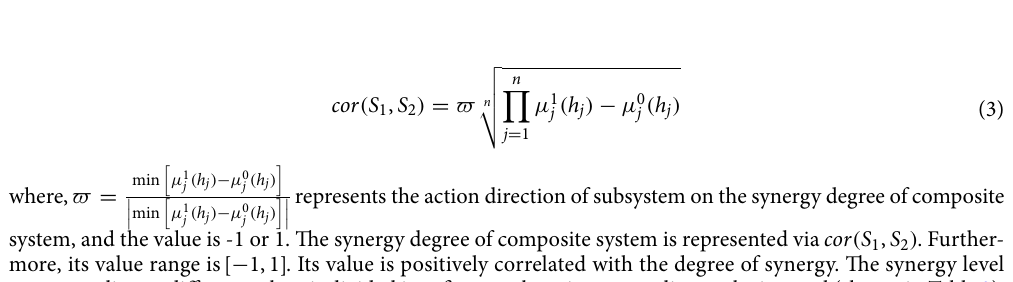
Table 2. Synergy level division table of composite